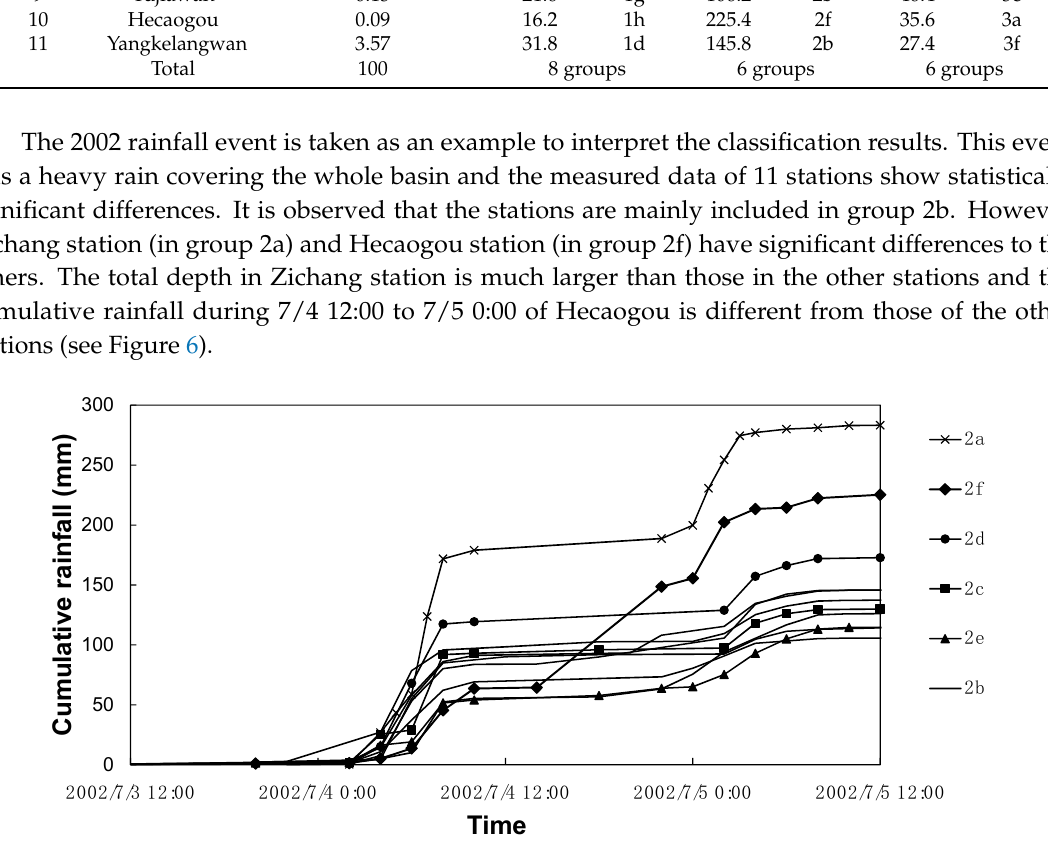
Figure 6. Cumulative rainfall of each station in the 2002 rainfall event in the upstream of the Qingjian River basin.